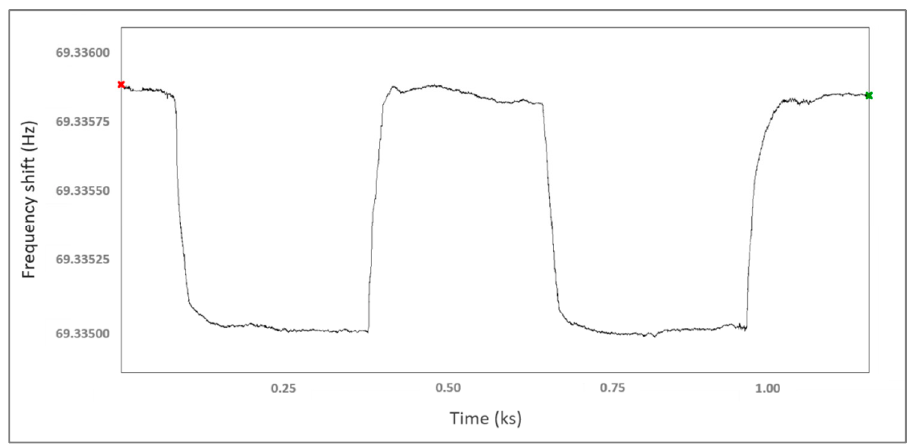
Figure 9. Dynamic response of sensor Pd-700/SnO 2 -700 at 0.4% hydrogen concentration. Table 2. Sensitivity and limit of detection (LOD) of the sensors ( ∆ f-frequency change; c-hydrogen concentration, n-noise